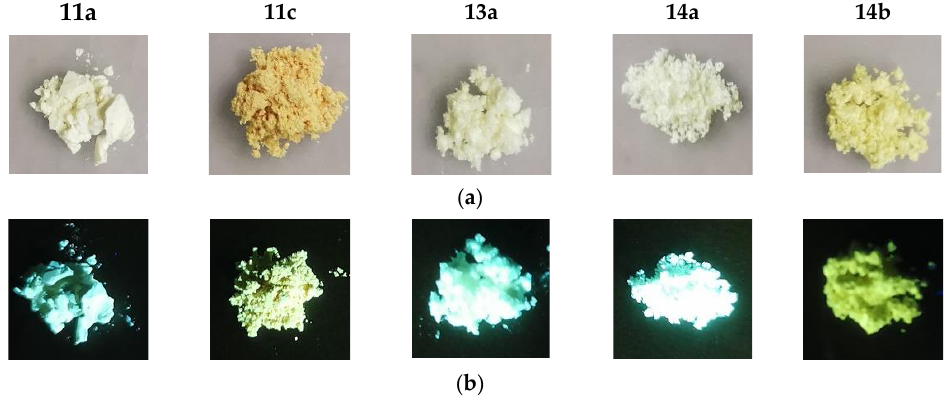
Figure 6. ( a ) Fluorescence spectra of DATs 11a , c , 13a , and 14a , b in a solid state; ( b,c ) photographs of DATs 11a , c , 13a , and 14a , b in a solid state under ( a ) daylight and ( b ) UV radiation with a hand-held UV lamp at an emission wavelength of 365 nm. Table 3. Photophysical characteristics of DATs 11a , c , 13a , and 14a , b in a solid state. Entry